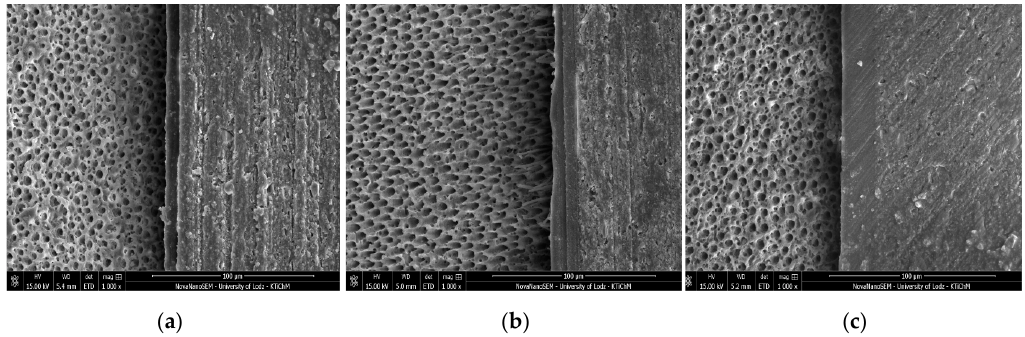
Figure 2. SEM images of adhesive layers obtained by application of Xeno V: ( a ) one layer; ( b ) two layers; ( c ) three layers; mag. 1000x. Molecules 2019 , 24 , x FOR PEER REVIEW